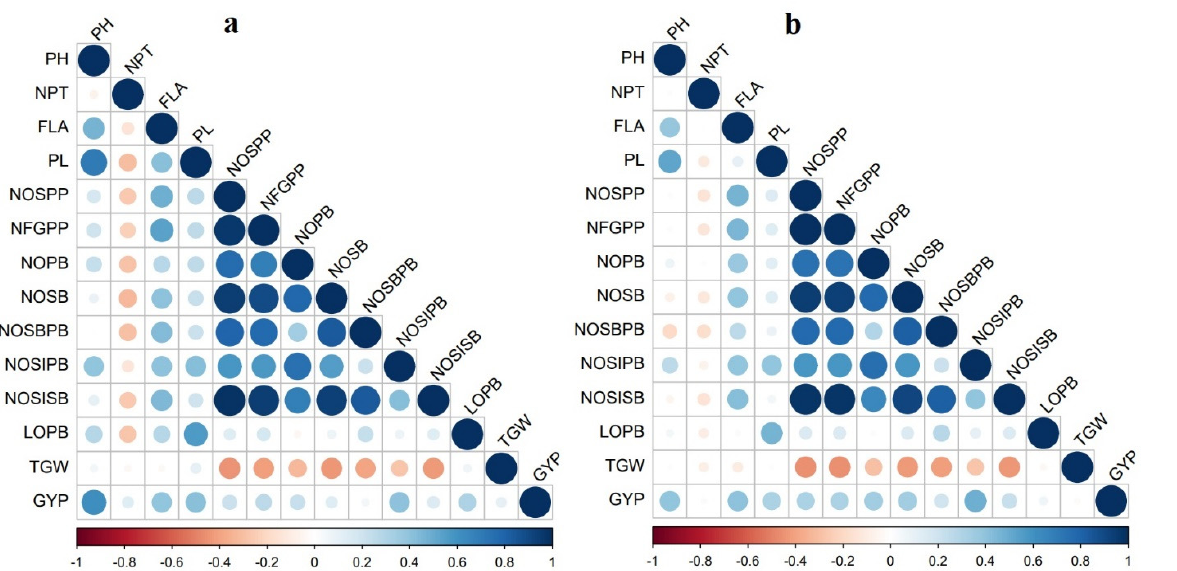
Table 6. Analysis of variance for RBD and combining ability effects for diallel analysis method I model 1.